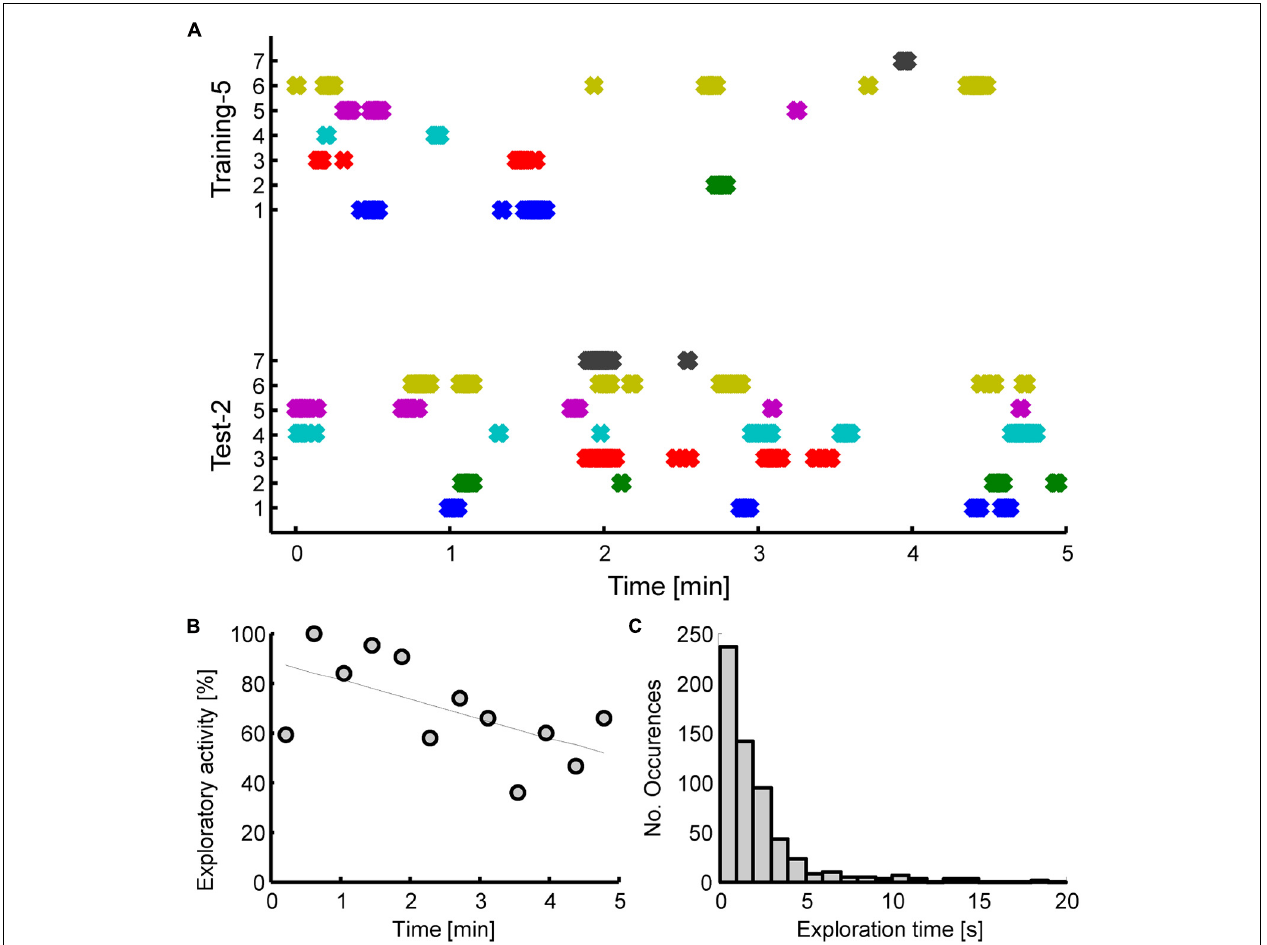
spent exploring. Continuous shaded regions thus represent multiple overlapping symbols and correspond to continued exploration. (B) Time course of overall exploration time for all objects during the first 5 min of exploration for all training and test sessions considered together. (C) Distribution of duration of exploration for individual contacts with the target objects (O1, O2, or O3).